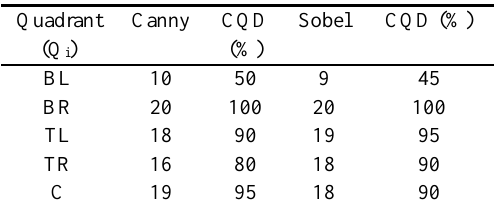
Table 2. Results of quadrant detection for both canny & sobel.